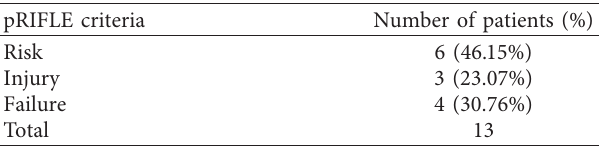
Table 5: AKI in children with dengue fever. Among 13 patients with AKI in children with dengue fever, mostly 46.15% had risk, and 23.07% had only injury managed conservatively. 30.76% had failure requiring peritoneal